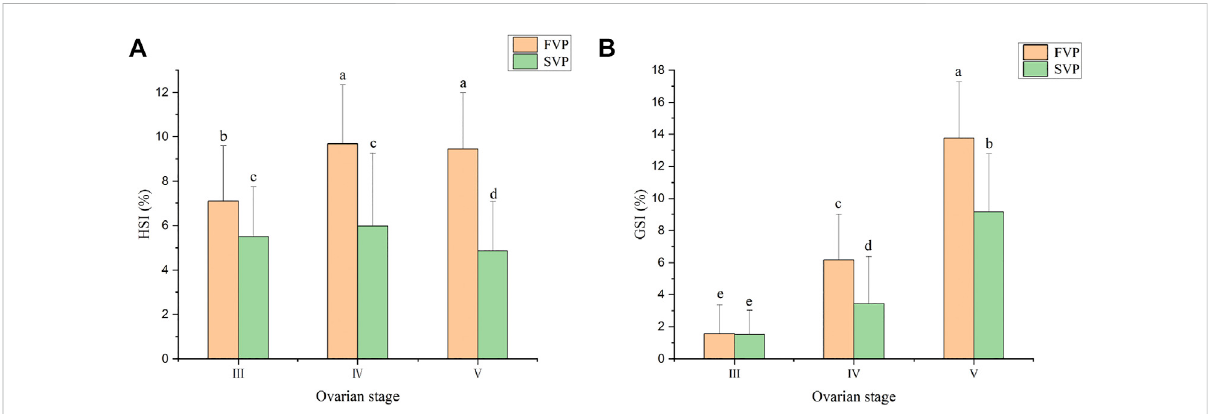
FIGURE 6 The GSI and HSI of S. paramamosain during the two vitellogenesis periods. (A) The HSI of S. paramamosain during the FVP and SVP. (B) The GSI of S. paramamosain during the FVP and SVP.